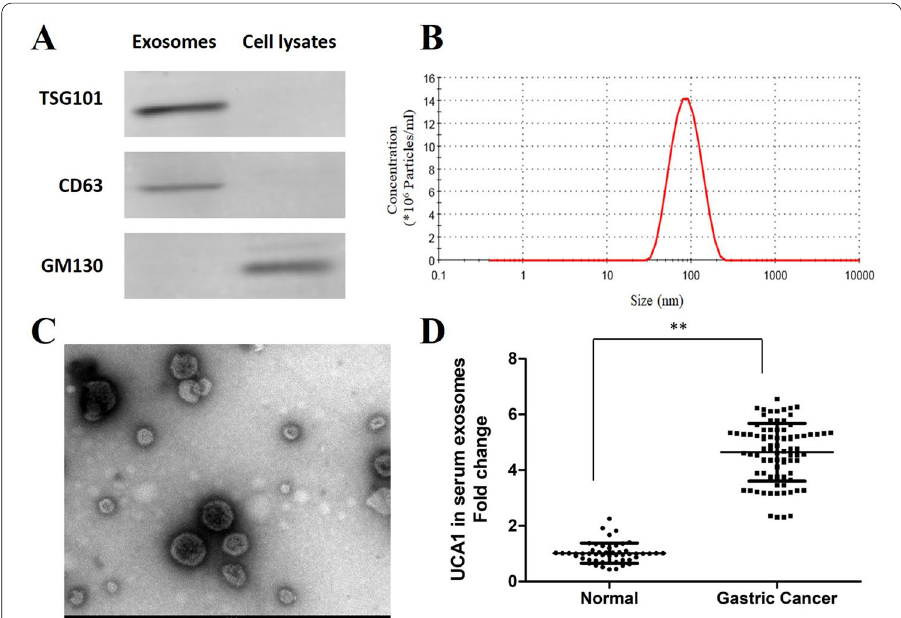
Fig. 1 UCA1 expression increased in serum exosomes from GC patients. A Western blot results showing the exosomal markers (TSG101, CD63, and GM130) expressed in serum exosomes of GC patients. B DLS results showing the exosomes size distribution. C Representative image of exosomes detected by TEM. D Q-PCR results for the UCA1 expression level in serum exosomes from GC patients and normal individuals. **p < 0.01 in comparison with normal